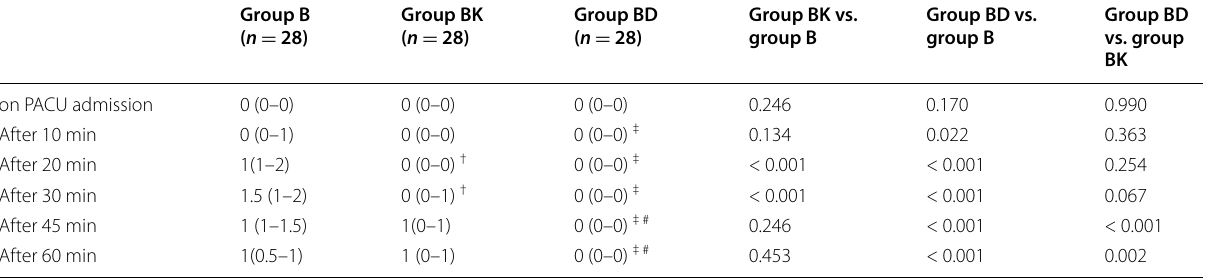
† Statistically significant ( P value < 0.05) (group BK versus group B) ‡ Statistically significant ( P value < 0.05) (group BD versus group B) # Statistically significant ( P value < 0.05) (group BD versus group BK)